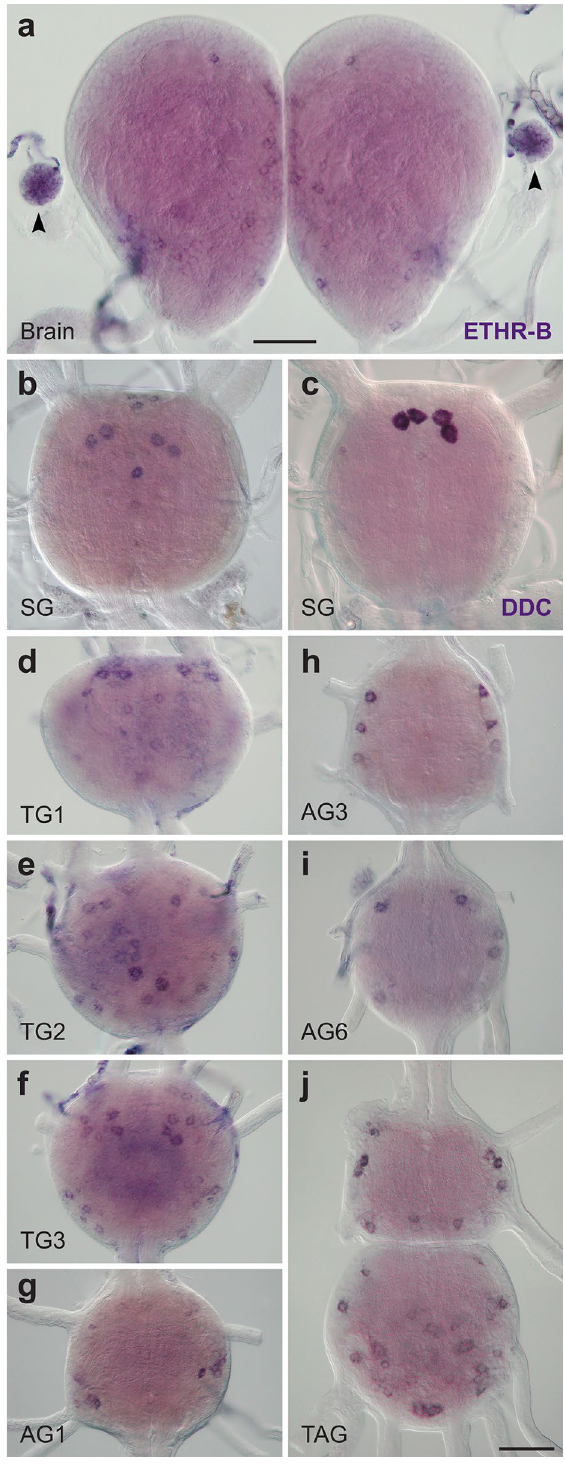
Figure 7. ETHR-B expression in the CNS of pharate larvae. ( a-j ) Neurons stained by ISH with probes for ETHR-B ( a–b , d–j ) or DDC ( c ). ( a ) ETHR-B transcript detected in numerous small medial neurons of the brain and endocrine cells of the CA (arrowheads). ( b ) In the SG ETHR-B was observed in several small medial neurons and four large cells that resemble those expressing DDC in the same ganglion ( c ). ( d–f ) ETHR-B expression in 4–8 large anterior cells and 6–10 additional neurons in the TG1-3. ( g–j ) ETHR-B staining in 4–6 pairs of dorsolateral neurons in the AG1-7 and 10–14 paired neurons in the posterior TAG. Scale bars = 50